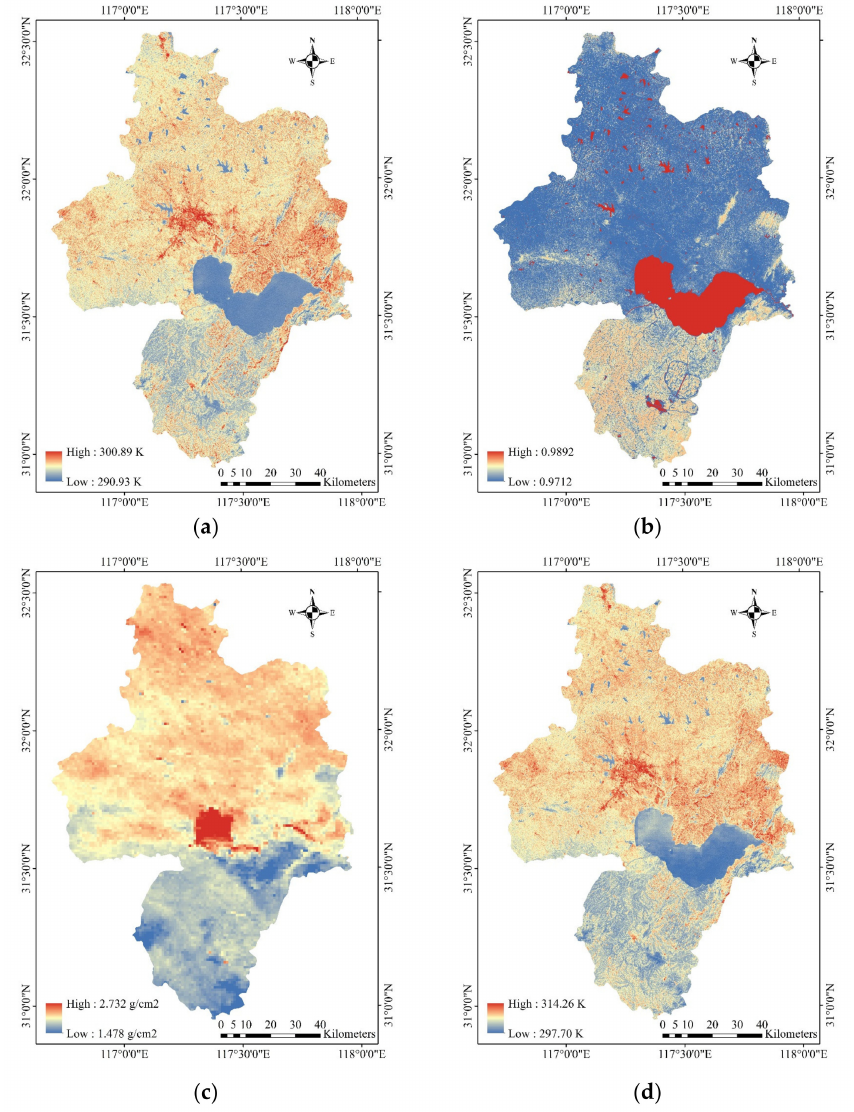
Figure 10. Spatial distribution LST with the three primary pre-processing products from Landsat TM, date 29 September 2002: ( a ) BT, ( b ) emissivity, ( c ) water vapor content, and ( d )